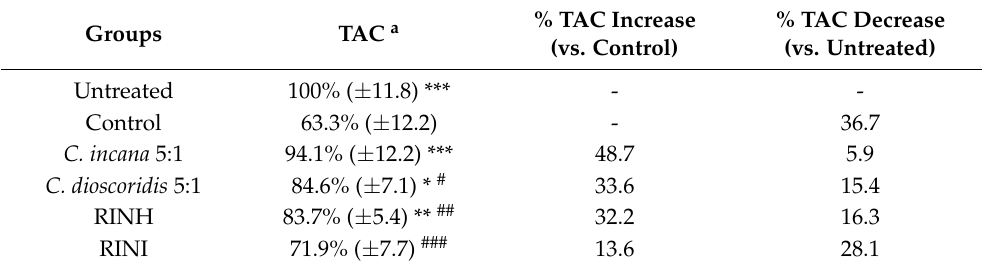
Table 4. Effect of extract C. incana 5:1, C. dioscoridis 5:1 and fractions RINH and RINI on TAC.